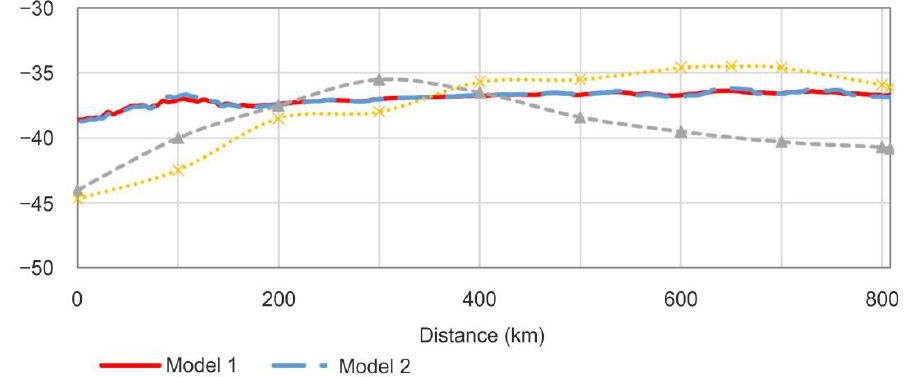
Figure 3. Present-day Moho depth from the models and open source data: dashed grey [37] and dotted yellow [42] lines.